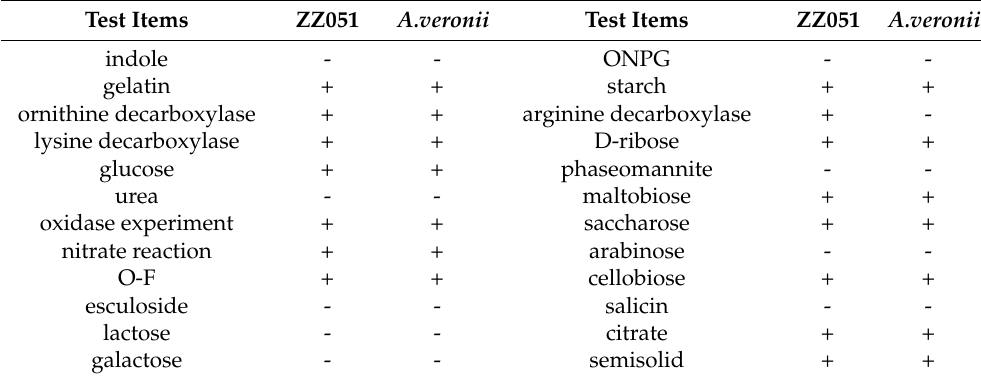
Note: +, positive; –, negative.